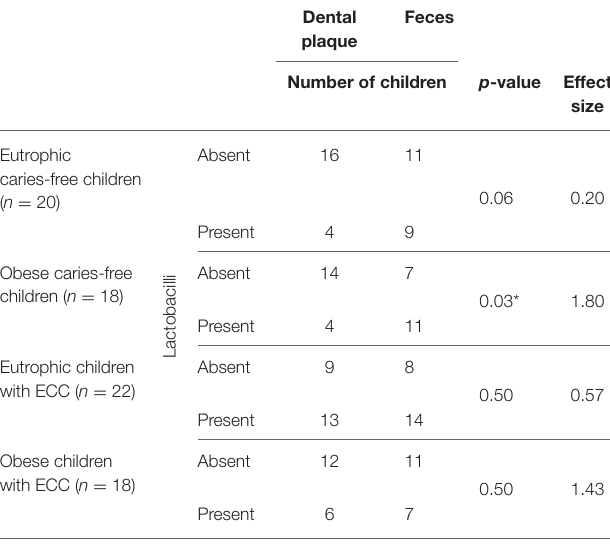
TABLE 2 | Comparison of mutans streptococci levels in the oral cavity and in the lower gastrointestinal tract of preschoolers, with respect to early childhood caries (ECC) and obesity.